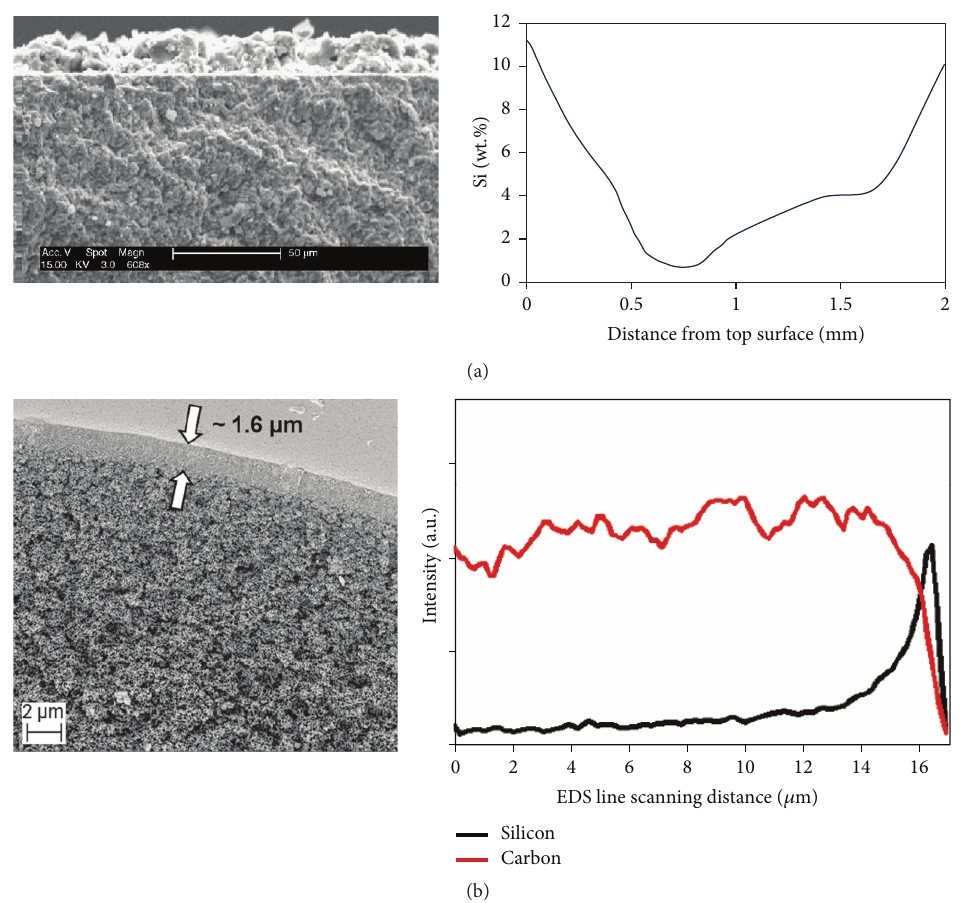
Figure 4: SEM images coupled with EDS line scanning analyses for (a) a flat MCM-48 membrane on an 𝛼 -alumina support [52] and (b) worm-like mesoporous silica membrane on a polymeric hollow fiber support